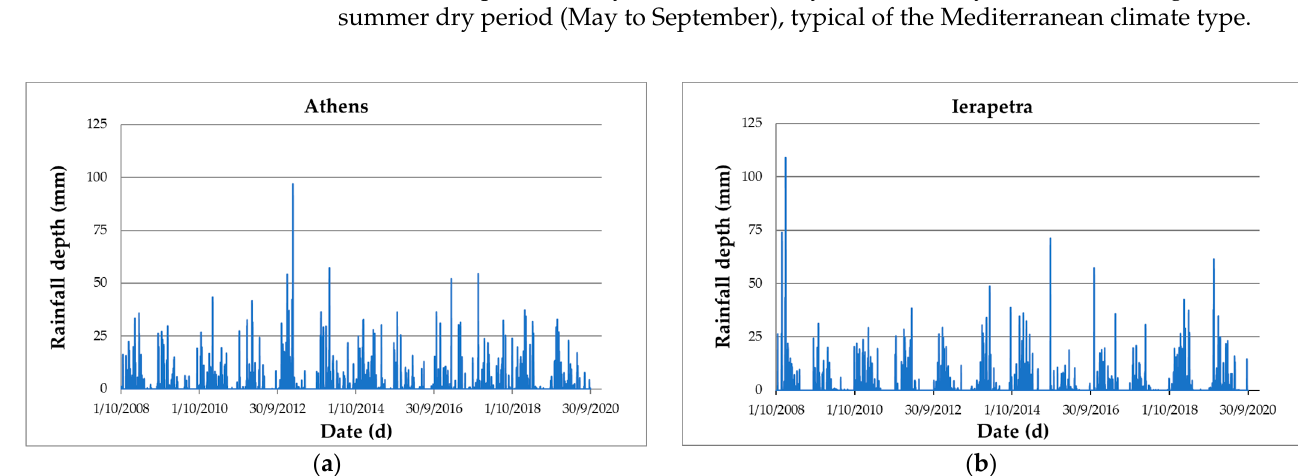
Table 2. Rainfall station characteristics, mean annual rainfall values ( P ), mean, max. and min. values of the longest annual